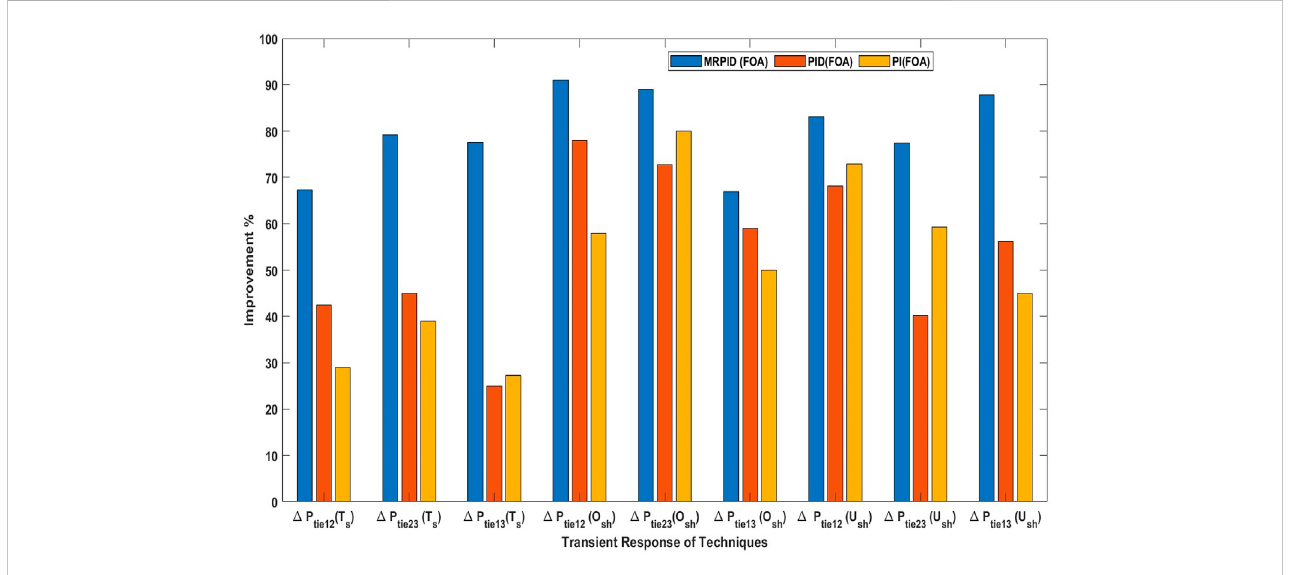
FIGURE 11 Comparison of different techniques for tie-line in terms of percentage